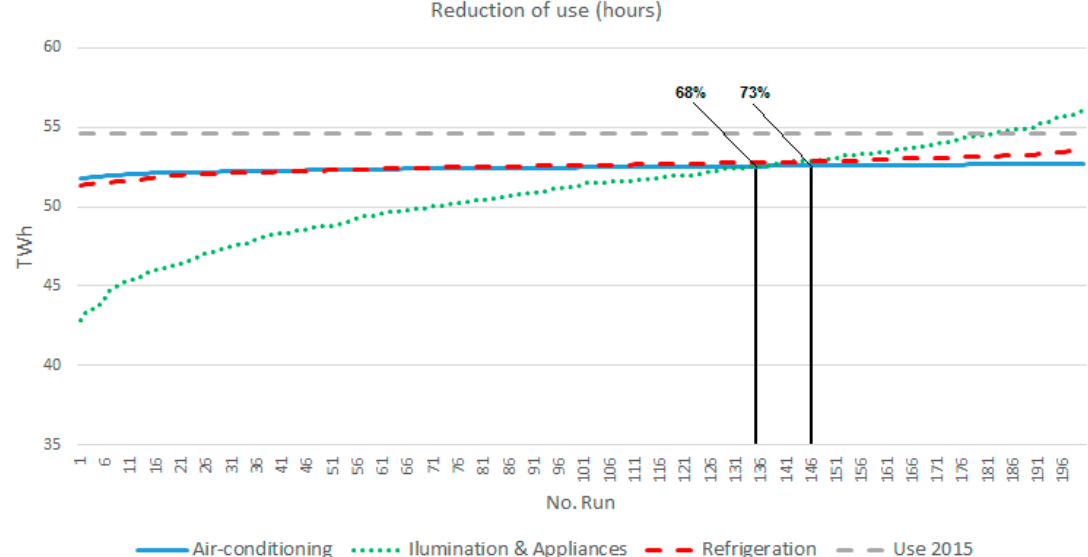
Figure 6. Estimated energy use by decreasing the time of use of devices upon the Mexican residential sector.